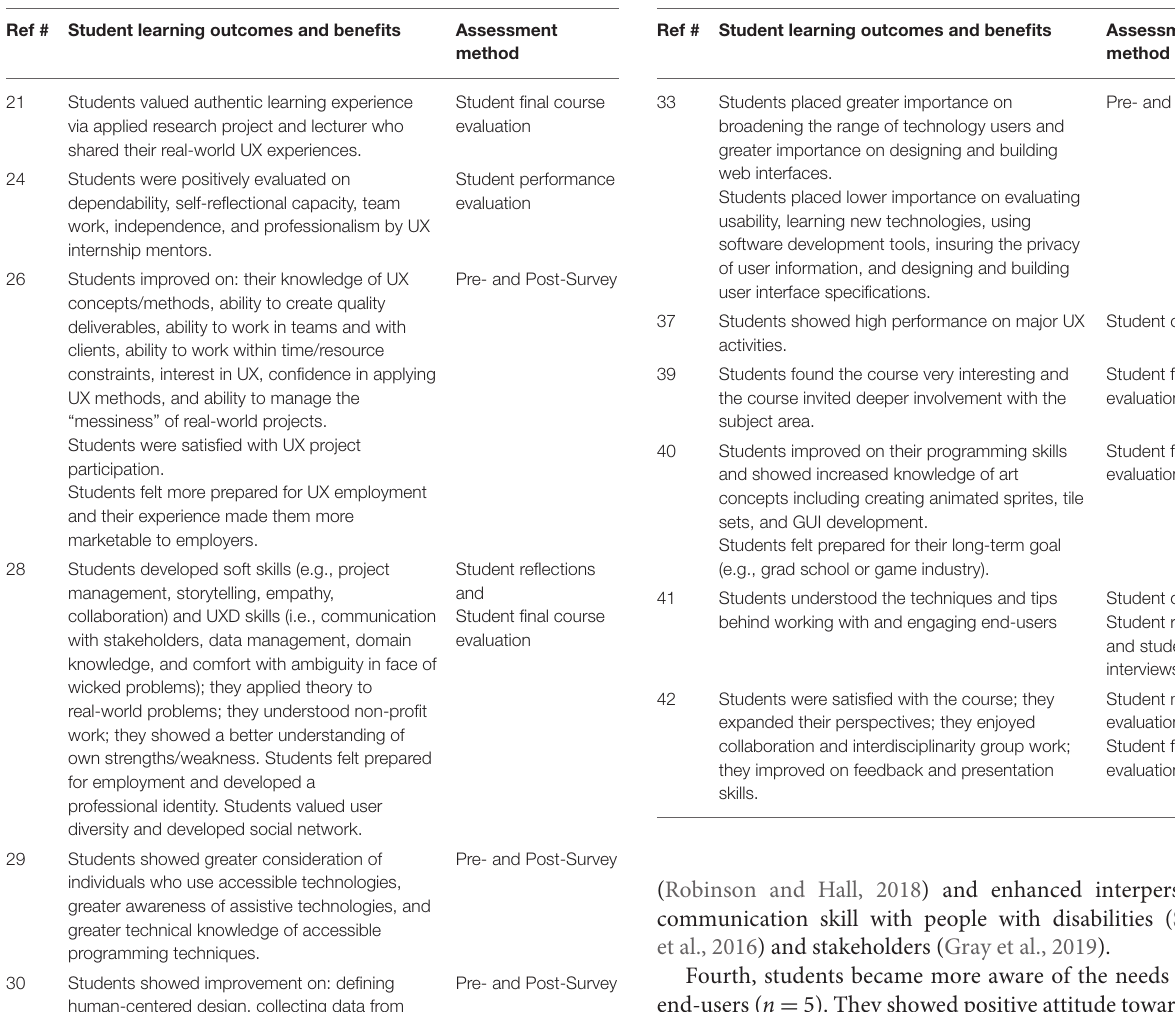
TABLE 9 | A list of learning outcomes and benefits reported in the articles. TABLE 10 | A list of learning outcomes and benefits reported in the